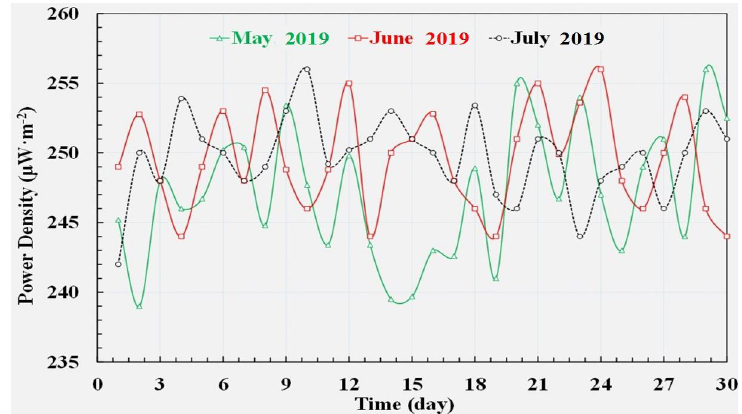
Figure 14. The power density of the energy harvesting system for three months .